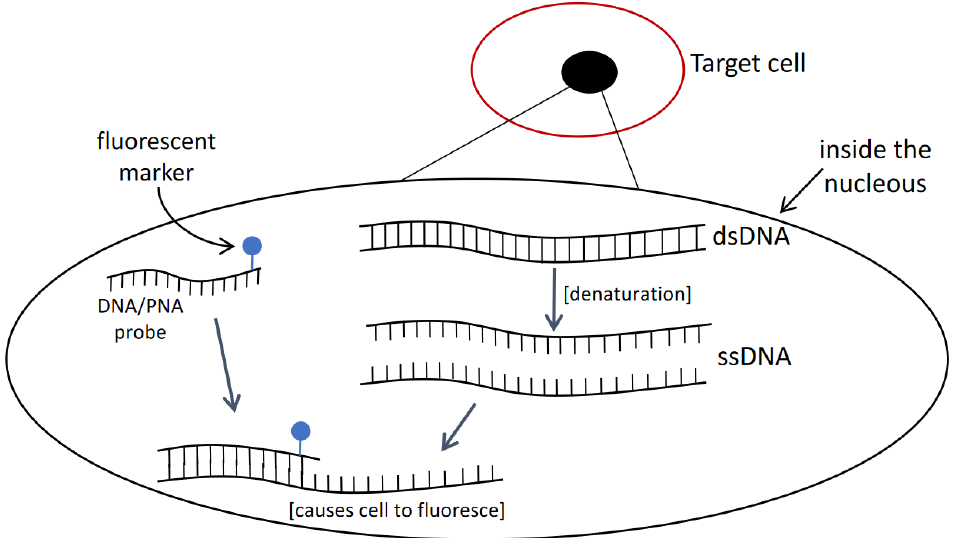
Figure 3. Principle of fluorescence in situ hybridization (FISH) technique. A method that utilizes fluorescent labelled probes to cause target cells to fluoresce.